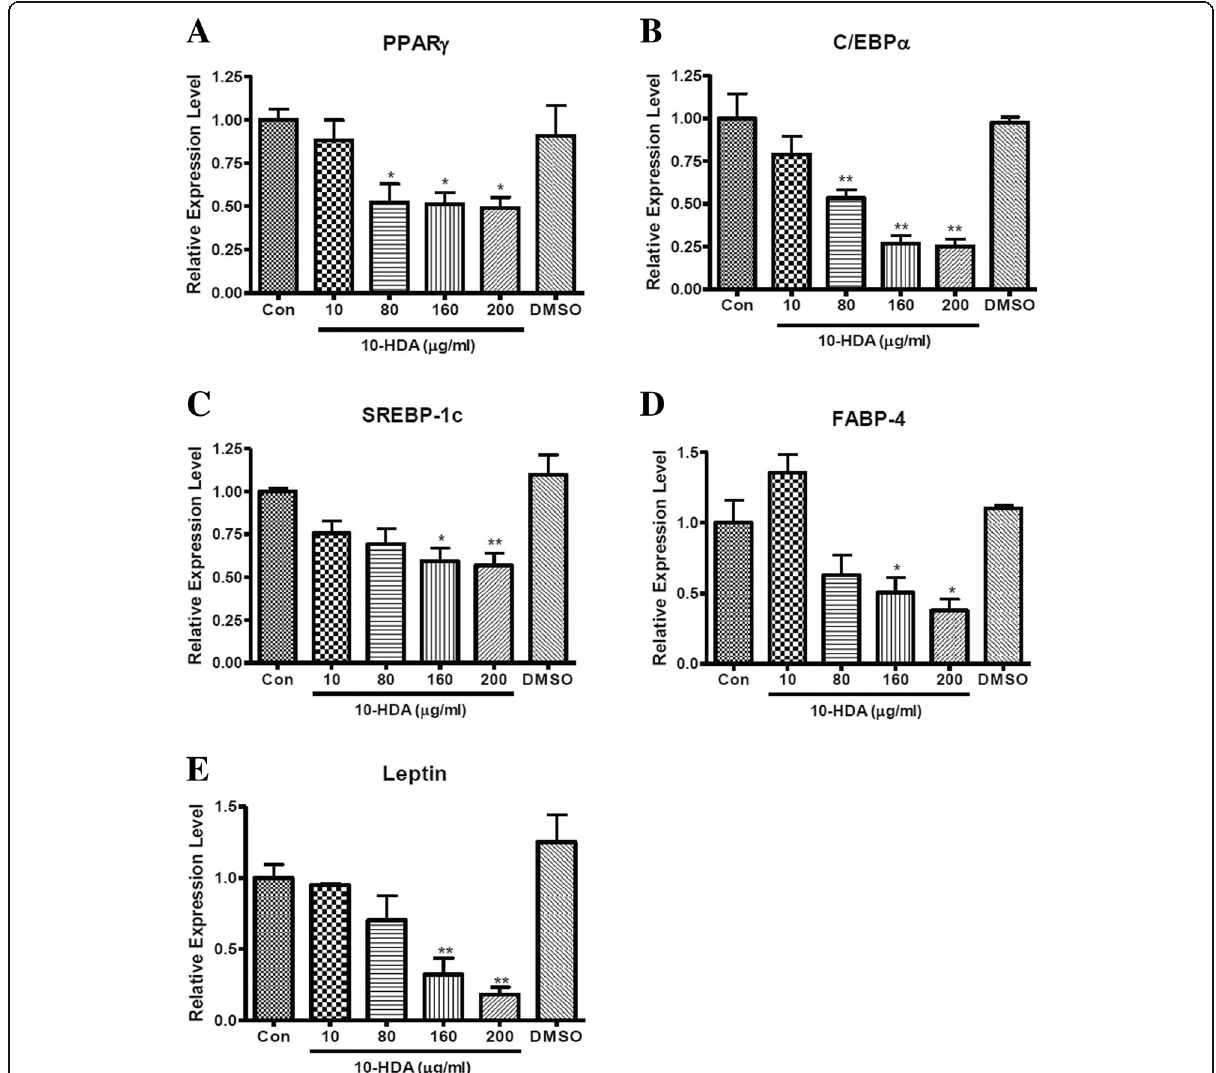
Fig. 5 Effects of 10-HDA on gene expression level of ( a ) PPAR γ , ( b ) C/EBP α , ( c ) SREBP-1c, ( d ) FABP4, and ( e ) Leptin during 3 T3-L1 adipocyte differentiation. Each gene expression levels were quantified and normalized to β -actin. The data shown are presented as means ± SEM of triplicate experiments. Statistical significance was calculated using one-way ANOVA followed by Dunnett ’ s multiple comparisons test. * P < 0.05 vs control; ** P < 0.01 vs